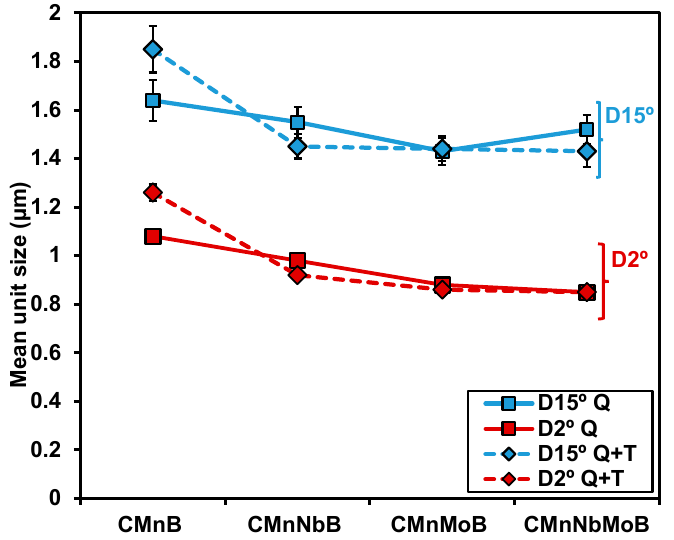
Figure 6. Mean Unit Sizes considering different misorientation criteria (tolerance angle of 2° and 15°) for both conditions: Q and Q + T cycles.